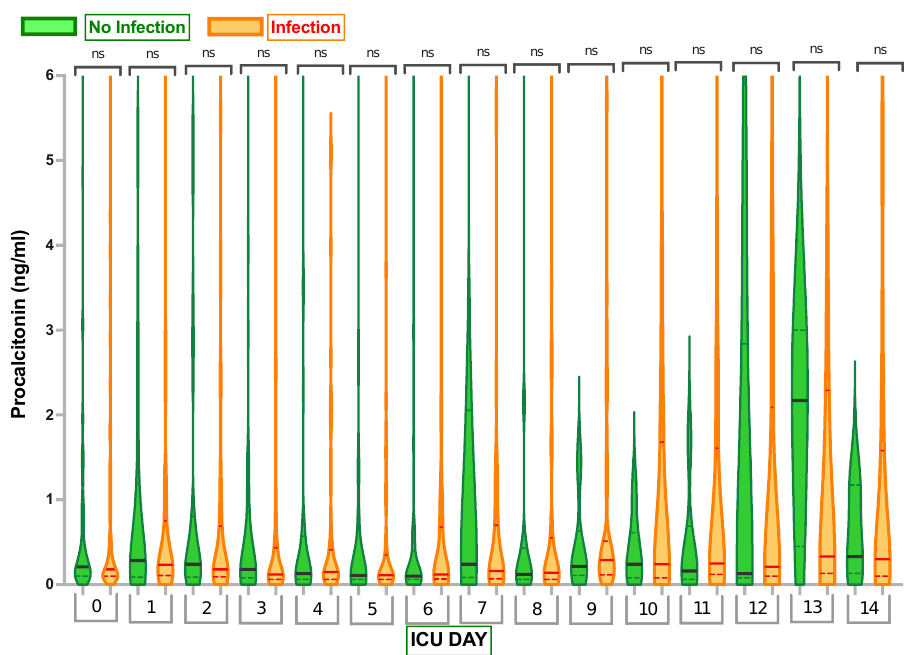
Figure 2. Comparison of Procalcitonin (PCT) Levels in Infection Group and No Infection Group. Violin plots represent the distribution of data. Hard lines show medians, and dashed lines show interquartile ranges. The y -axis represents Procalcitonin Levels in ng/mL. The x -axis represents Days in the Intensive Care Unit (ICU) with 0—Procalcitonin Level Day 0. ns—no statistically significant difference from the Independent Mann–Whitney U test or one-way analysis of variances (ANOVA).